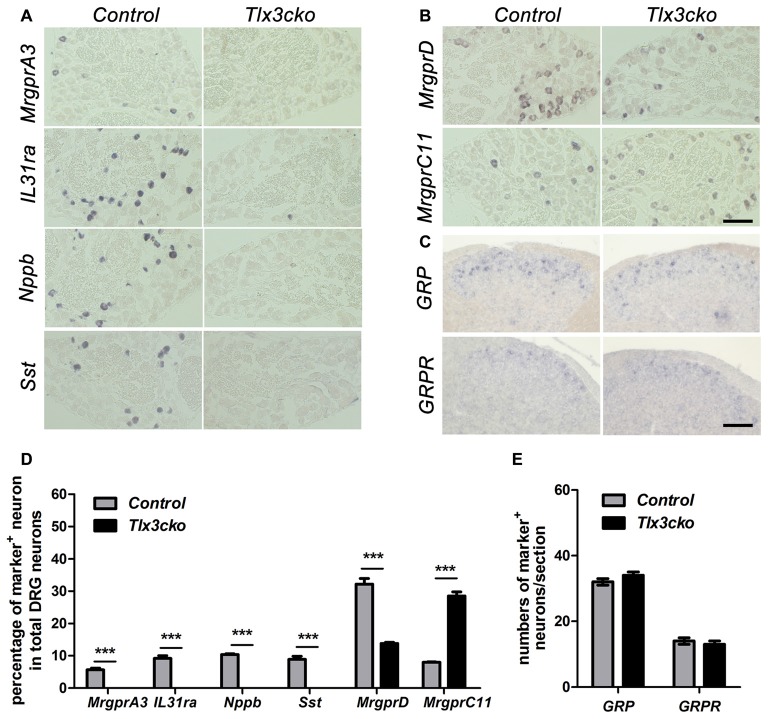
Expression of a subset of itch-related molecules in Tlx3cko dorsal root ganglions (DRGs) and spinal cords. In situ hybridizations with indicated probes were performed on transverse sections of lumbar DRGs (A,B) and spinal cords (C) from adult control and Tlx3cko mice, the statistical data were shown on (D,E). Compared with that in control mice, expression of MrgprA3, IL31ra, Nppb and Sst were almost completely eliminated in Tlx3cko mice (A). The percentage of MrgprD+ neurons in Tlx3cko mice was markedly reduced (control, 32.2% ± 1.7%, n = 3; Tlx3cko, 13.8% ± 0.4%, n = 3; p = 0.0004). The percentage of MrgprC11+ neurons was greatly increased in Tlx3cko mice (control, 8% ± 0.1%, n = 3; Tlx3cko, 28.5% ± 1.3%, n = 3; p < 0.0001) (B). (C) The numbers of GRP+ and GRPR+ neurons in the spinal cords of Tlx3cko and control mice were comparable (GRP+ neruons : control, 32 ± 1/section; Tlx3cko 34 ± 1/section; n = 28–32 sections from 3 mice, p = 0.3753; GRPR+ neurons: control, 14 ± 1/section; Tlx3cko 13 ± 1/section; n = 22–23 sections from 3 mice, p = 0.8294). ***Indicates p < 0.001, Scale bar represents 100 μm.